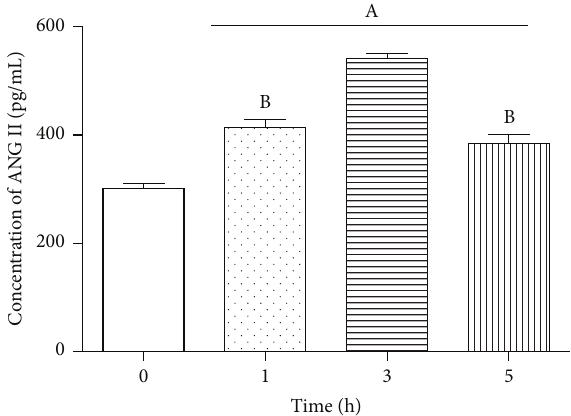
Figure 3: Concentrations of ANG II secreted by 3T3-L1 adipocytes after being treated with PA + Fet A at different time. Data are presented as mean ± SD. (A) 𝑃 < 0.05 versus control, (B) 𝑃 < 0.05 versus 3 h ( 𝑥 ± 𝑠 , 𝑛 = 6